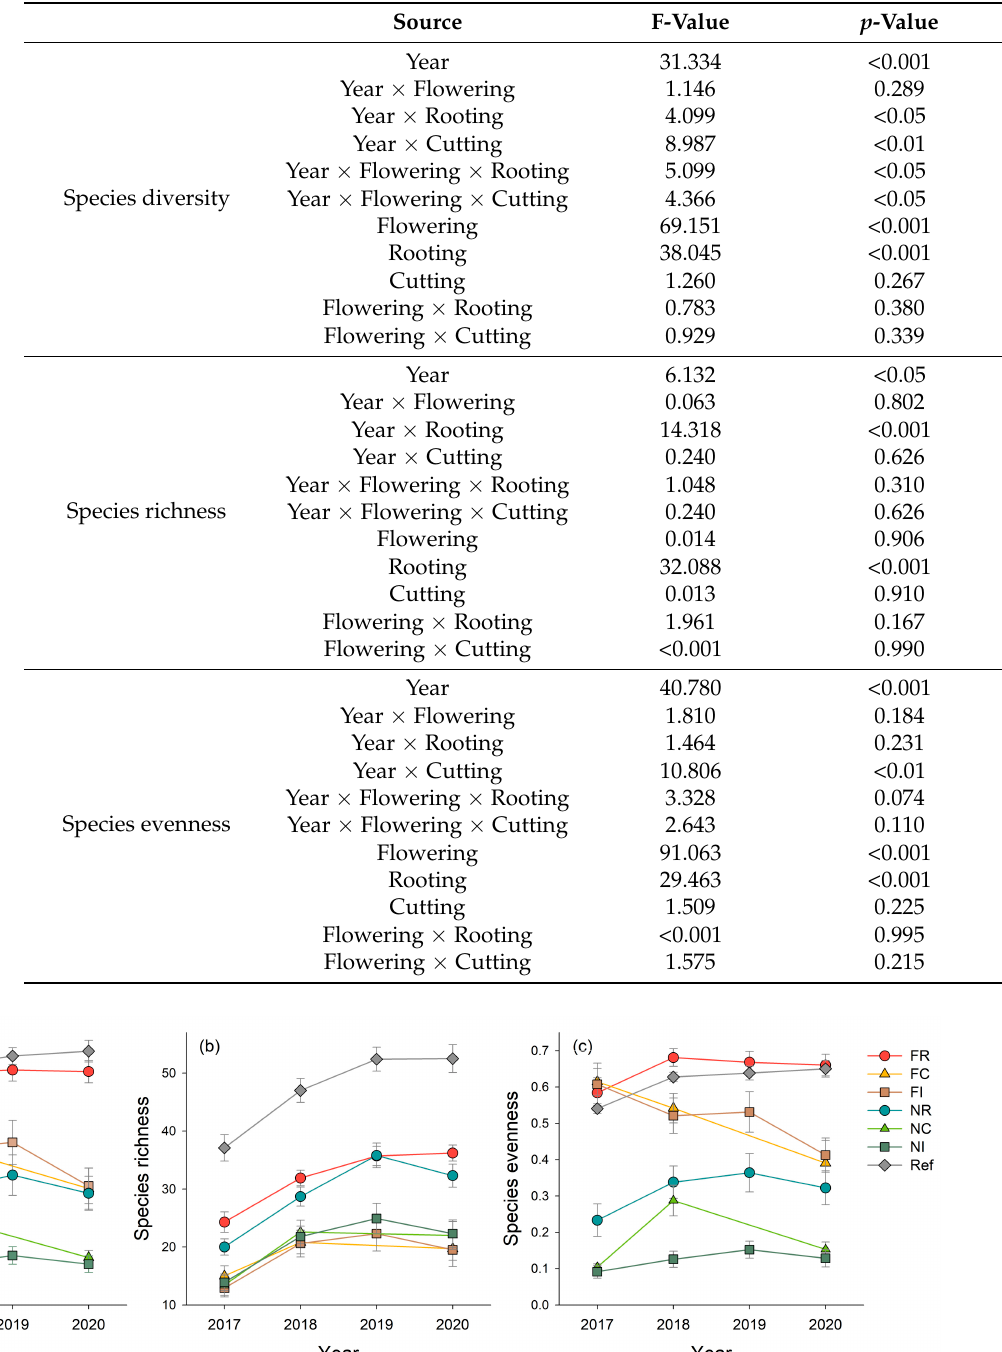
Table 2. Repeated measures analysis of variance for the effects of flowering, rooting, and cutting on species indices.